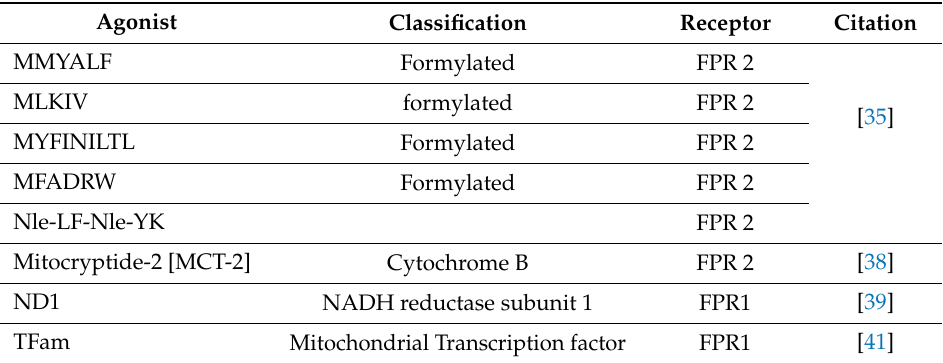
Table 2. Mitochondrial peptide ligands for FPRs